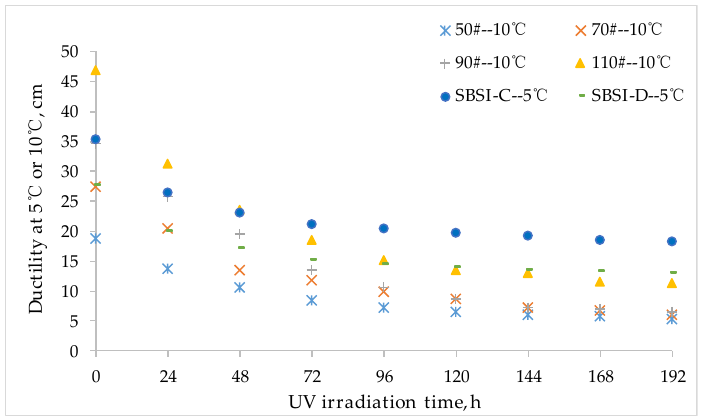
Figure 8. The ductility of asphalt with different UV irradiation time (the test temperature of base asphalt is 10 °C while that of SBS modified asphalt is 5 °C).